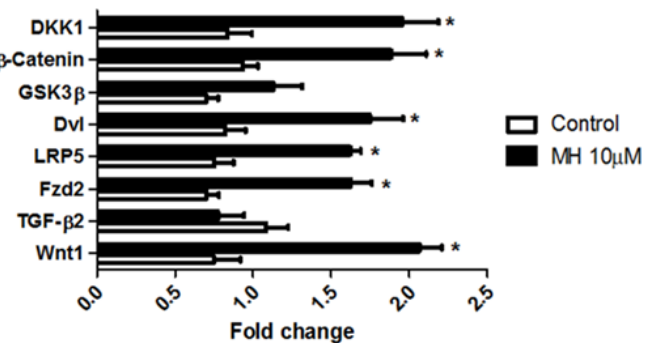
Figure 8. MH controls the Wnt signal transduction pathway, a main regulator of development. Real-time RT-qPCR was performed on total RNA isolated from each group of embryos using described primers in Table 1, leading to the amplification of the target gene. RT-qPCR analysis of Wnt 1, transforming growth factor beta 2 (TGF- β 2), frizzled 2 (Fzd2), low-density lipoprotein receptor-related protein 5 (LRP5), dishevelled (Dvl), glycogen synthase kinase 3 beta (GSK-3 β ), β -catenin, and dickkopf 1 (DKK1) isolated from the control and MH-treated embryos. Each value represents mean ± SEM ( n = 100, replicated four times). Statistical analysis was performed by two-way ANOVA followed by post-hoc Bonferroni test. * indicates values which are significant versus the respective control group ( p < 0.05).